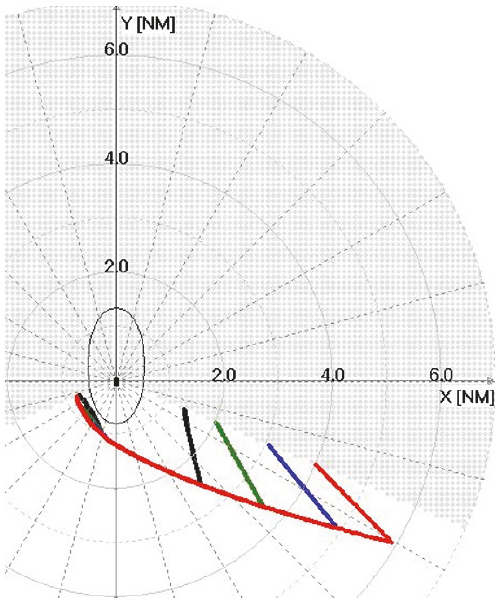
Figure 15: Action lines for being overtaken by a target, whose true speed is 23 knots. Assumed are turns to starboard by 90 ∘ (red), 100 ∘ (blue), 120 ∘ (green), and 150 ∘ (black). No speed